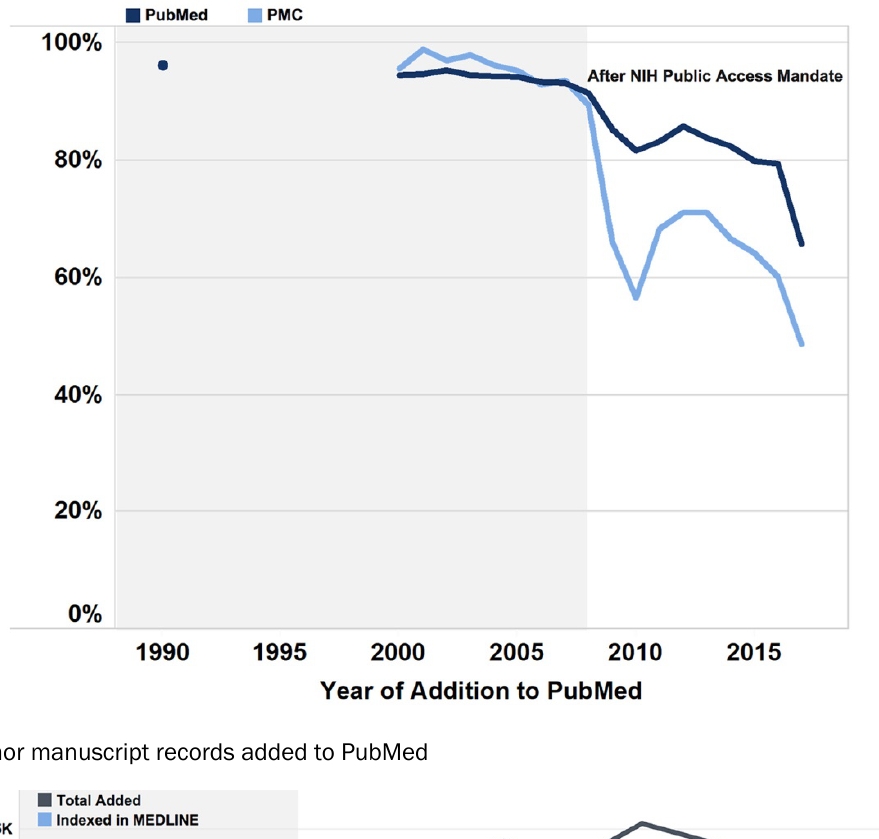
Figure 5 Percentage of new PubMed and PMC records indexed in MEDLINE